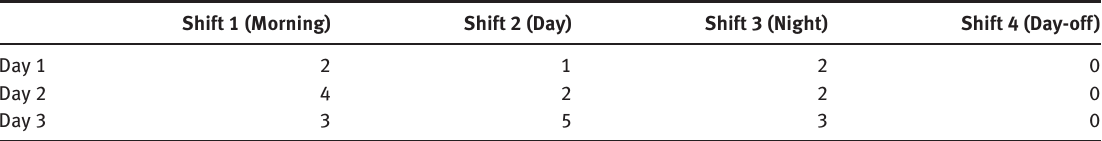
Table 2: An Illustration of Coverage Matrix.